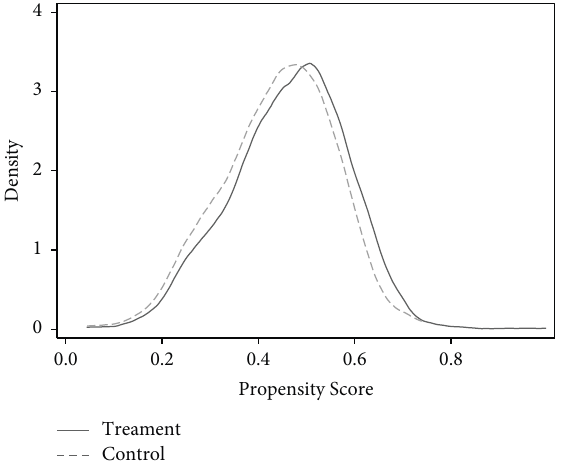
Figure 2: After propensity score